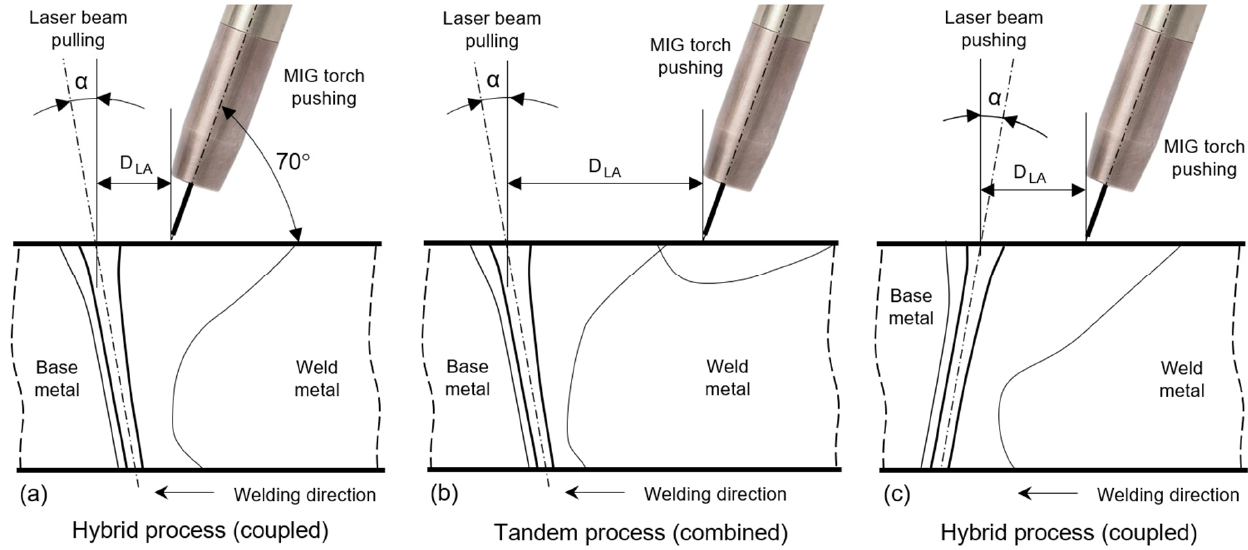
Figure 10. Process variation according to distance length between laser beam and arc source in case of trailing arc (leading laser) position. ( a ) Shows hybrid and ( b ) tandem process with pulling keyhole position, and ( c ) hybrid process with pushing keyhole position. D LA is the process distance between the laser beam axis and filler wire tip, α is the angle from the laser beam axis to normal and taken as 10°.